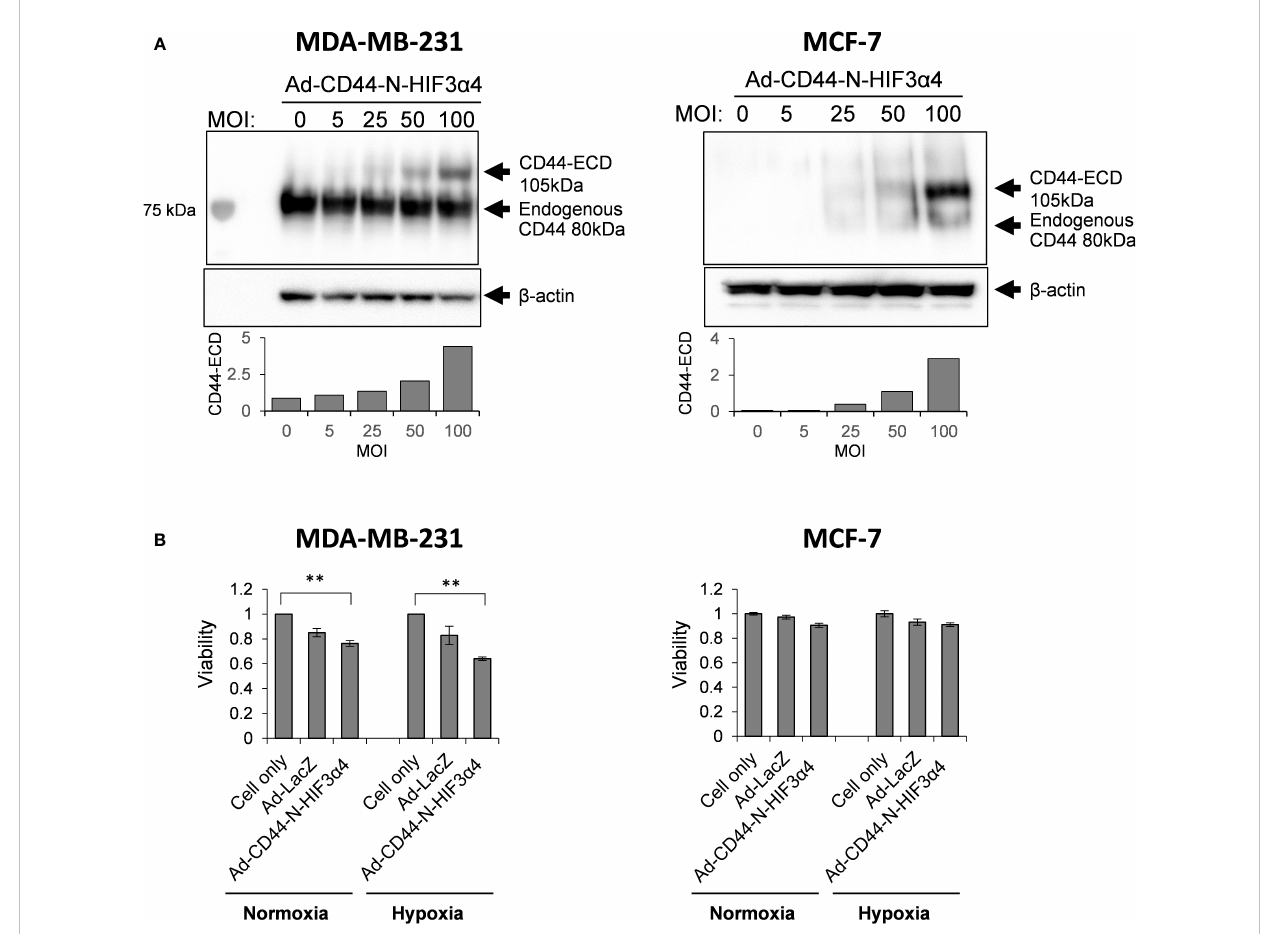
FIGURE 4 Ad-CD44-N-HIF3 a 4 transduced CD44-ECD protein in MDA-MB231 and MCF-7 cells in dose-dependent manner but inhibits the cell growth of only MDA-MB-231 cells (A) Western blotting using anti-CD44 antibody revealed that MDA-MB-231 highly expressed endogenous CD44 protein (around 80 kDa) but MCF-7 does not express the endogenous CD44 protein. Ad-CD44-N-HIF3 a 4 could induce the synNotch receptor protein including CD44-ECD in dose dependent manner both in MDA-MB-231 and MCF-7. (B) Cell proliferation analysis, Ad-CD44-N-HIF3 a 4 signi fi cantly inhibited the cell growth of MDA-MB-231 cells in normoxia and hypoxia conditions compared to cell only (no treatment) group but did not inhibit the cell growth of MCF-7 cells (n=3, average ± SE bars, **p<